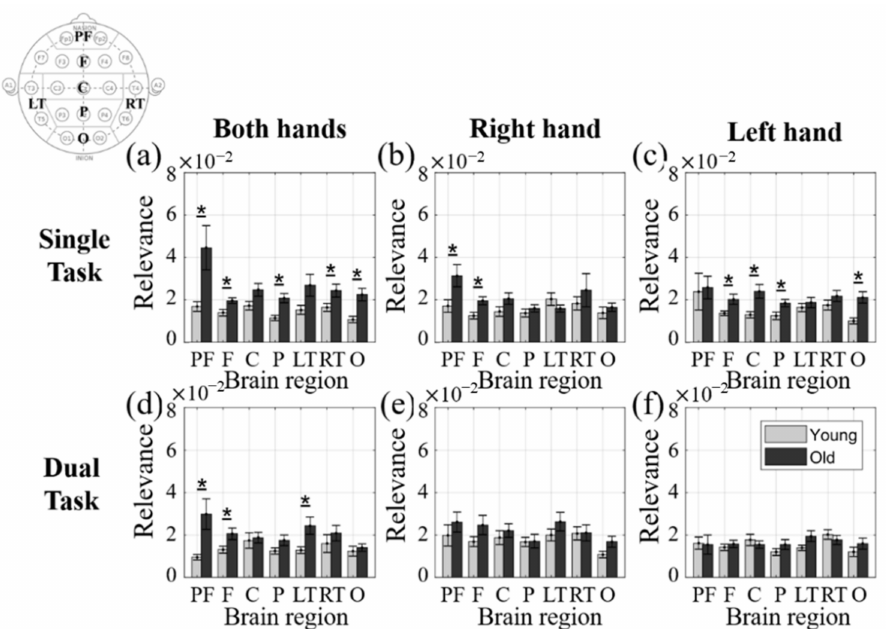
Figure 8. Bar graphs of the relevance values of inter-regional HiFC in ( a ) Single both , ( b ) Single right , ( c ) Single left , ( d ) Dual both , ( e ) Dual right , and ( f ) Dual left . The defined brain regions are presented in the top left corner. Gray- and black-colored bars represent the younger and older groups, respectively. The asterisks indicate the significant differences in the relevance values between the younger and older groups (two-sample t -test, p < 0.05). Table 2. Degree of Node ( k i ) and Average Nodal Degree ( K ) in the Network of the Inter-regional LoFC and HiFC for Seven Brain Regions.